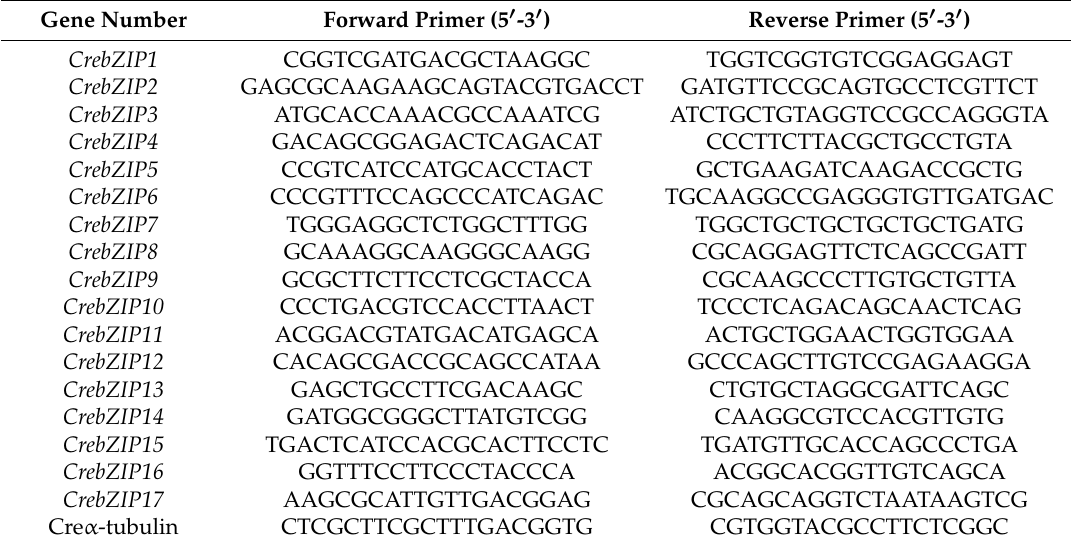
Table 3. Primer information of CrebZIP and reference genes for quantitative real-time (qRT)-PCR. Gene